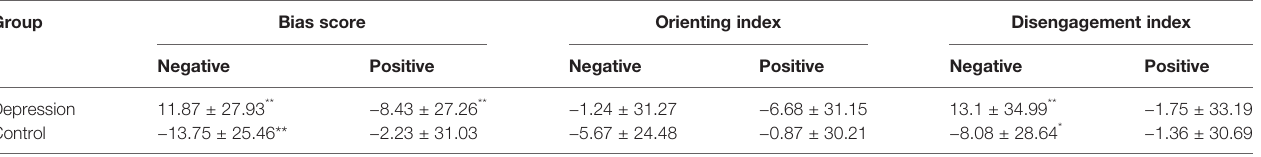
TABLE 2 | Bias score, orienting index, and disengagement index (s) for positive and negative stimuli [(x ± s)/ms)]. Group Bias